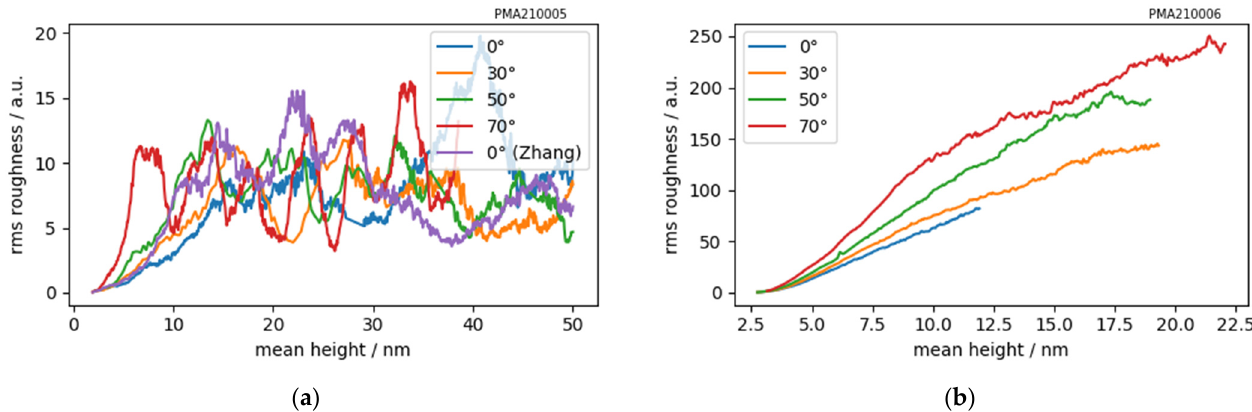
Figure 7. Surface roughness given as the integral of the power spectral density between 0.2 and 2 nm − 1 calculated by Welch’s method [18–21]. ( a ) 7 × 8 nm 2 substrate size, ( b ) 30 × 20 nm 2 substrate size.